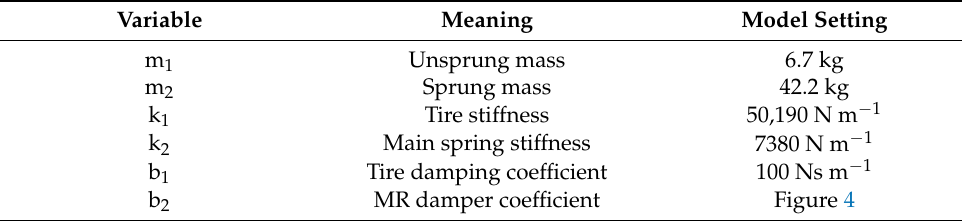
Table 1. Model Table 1. Model parameters.